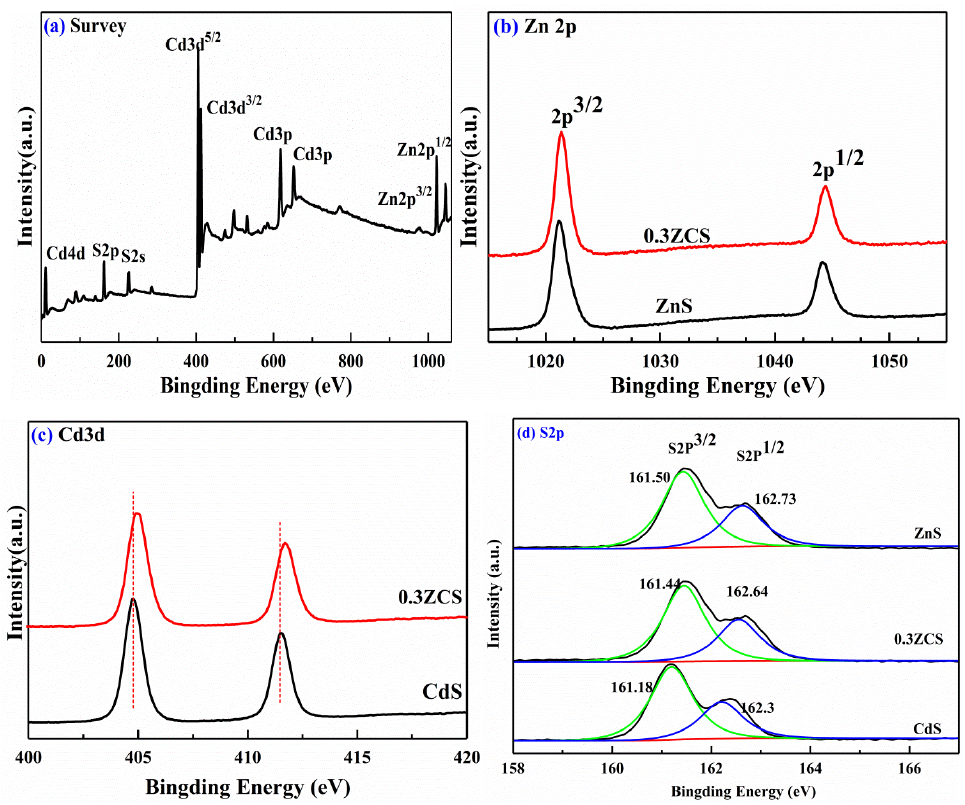
Figure 3. ( a ) Survey and high resolution ( b ) Zn 2p; ( c ) Cd 3d; ( d ) S 2p XPS spectra of the prepared 0.3ZCS sample.